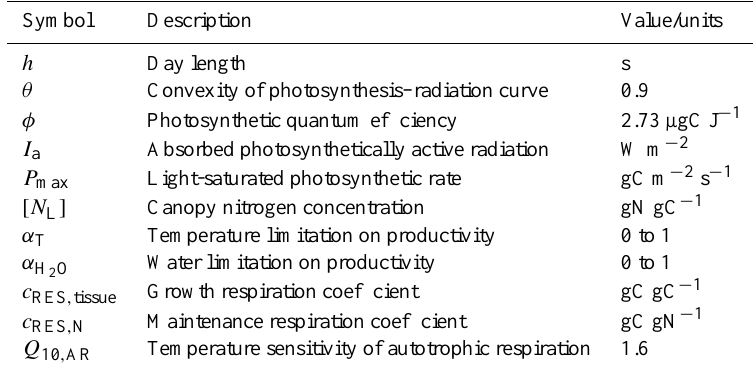
Table C4. Variables and parameters used in net primary productivity calculations.